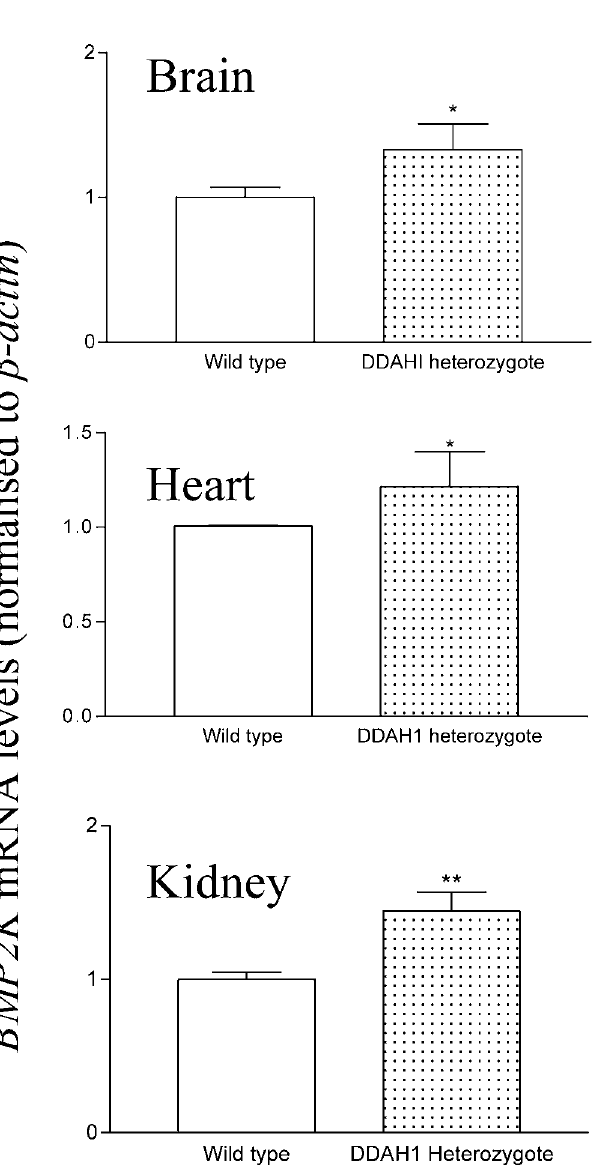
Figure 8. BMP2K Is Increased in DDAH1 Gene Deletion Mice Expression of BMP2K mRNA from brain, heart, and kidney is increased in 12-wk DDAH1 heterozygous knockout mice compared to wild-type litter- mates ( p ¼ 0.0473, p ¼ 0.0379, and p ¼ 0.0070, respectively); mRNA was corrected for differences in b -actin mRNA expression, where n ¼ 5 wild type, and n ¼ 9 DDAH heterozygous. DOI: 10.1371/journal.pmed.0020264.g008